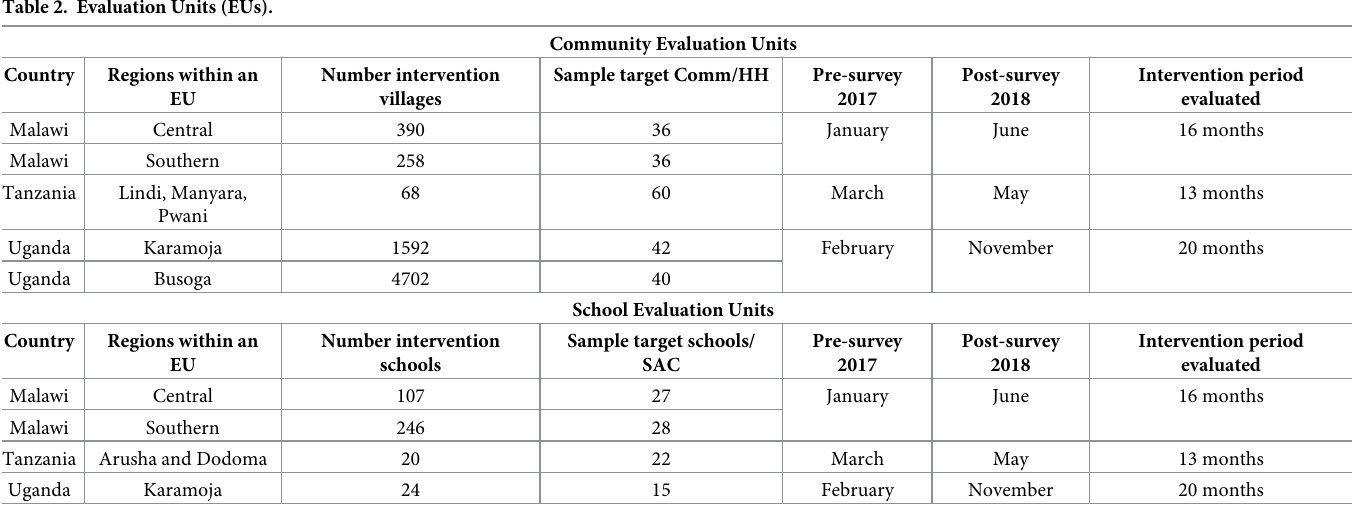
Table 2. Evaluation Units